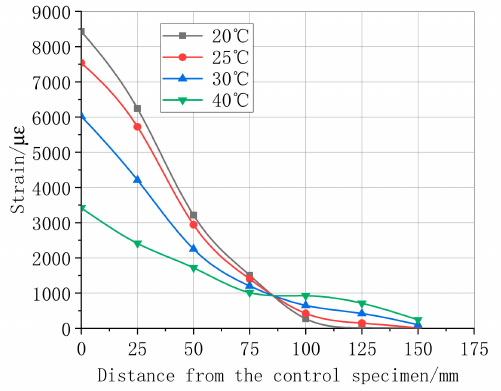
Figure 13. Ultimate strain of CFRP length 350 mm under di ff erent temperature.